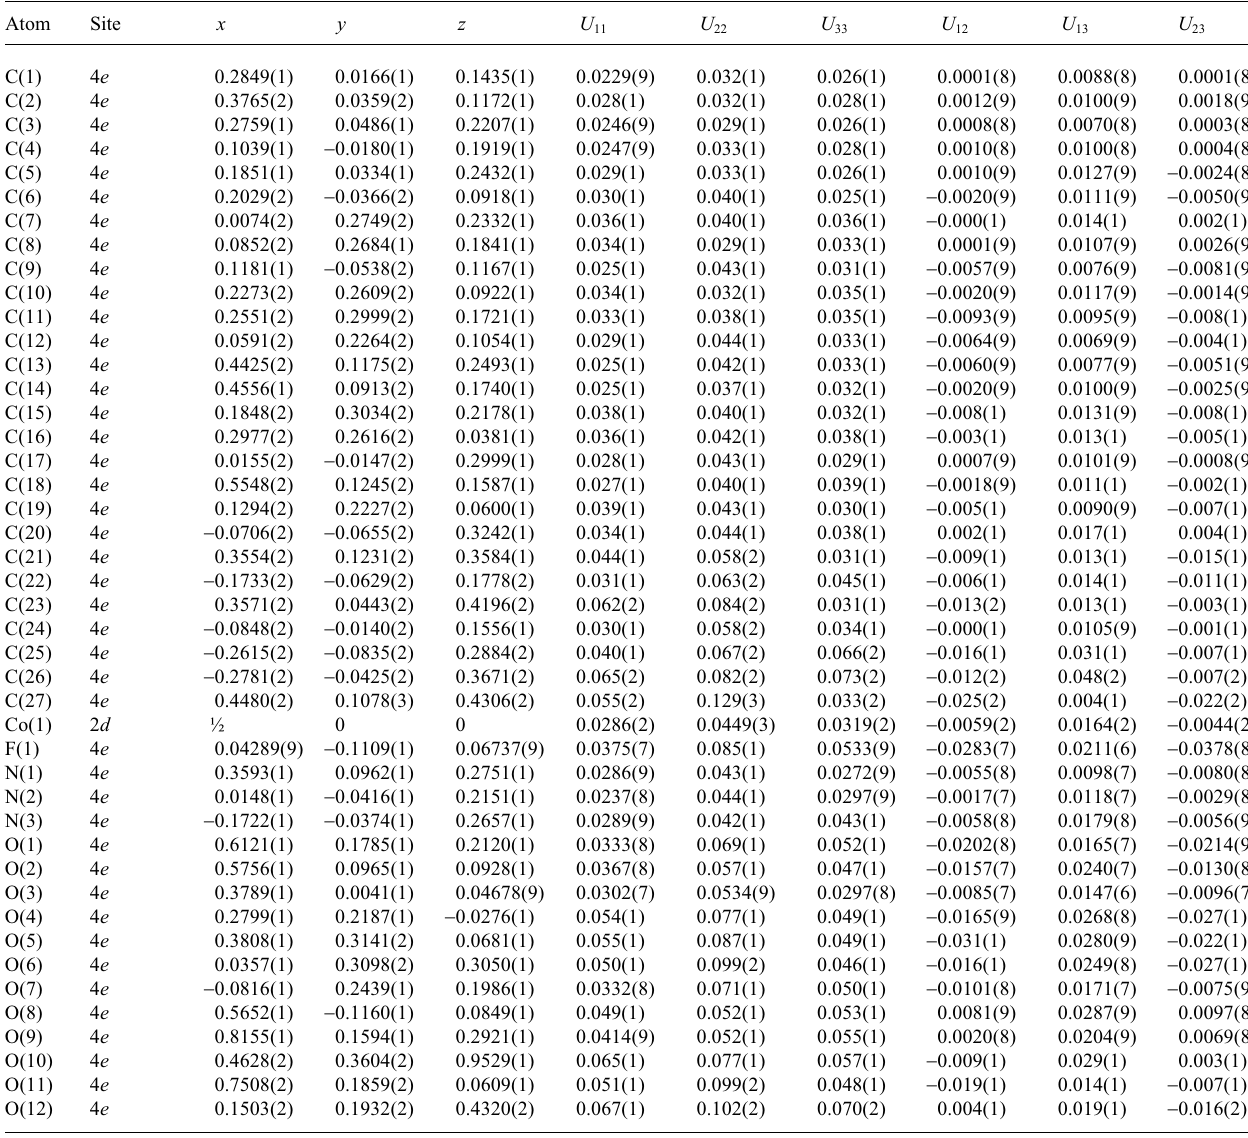
Table 3. Atomic coordinates and displacement parameters (in Å 2 )